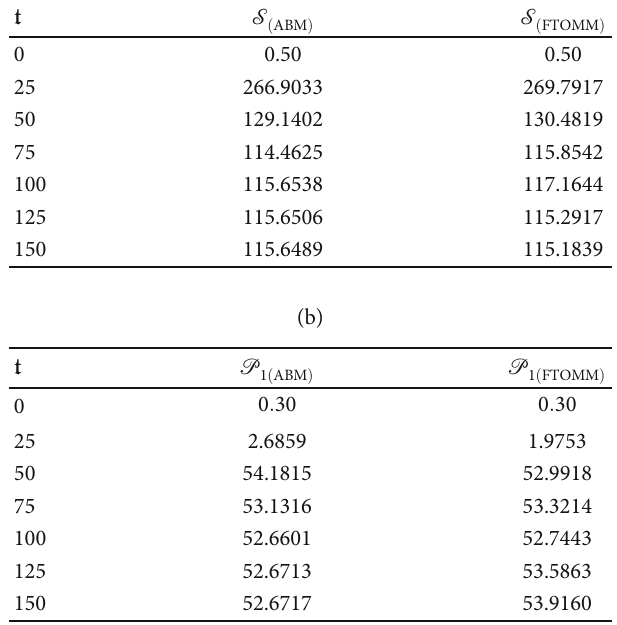
, (c) P , and (d) R ). 1 2